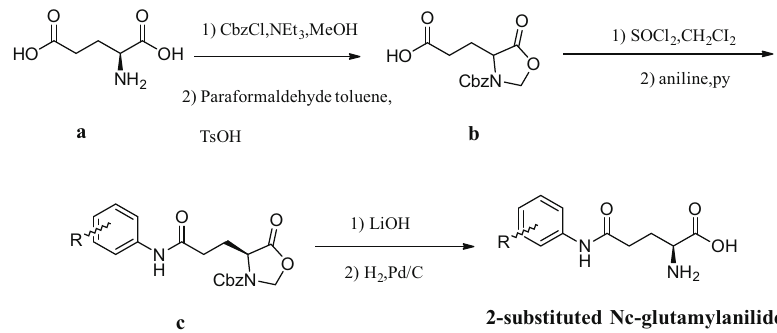
Figure 4: Synthetic route towards 2 - substituted Nc - glutamyl anilides ( Compound a as initial material, b and c as synthetic intermediates ) .